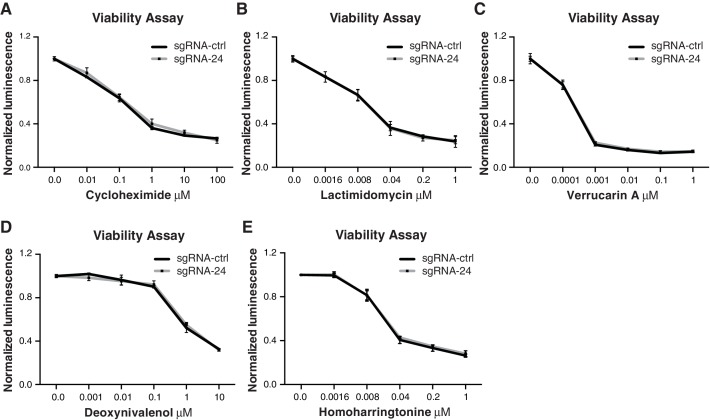
Effects of specific ribosome targeting drugs on the growth of HCC cells lacking SNORA24-guided rRNA modifications.Graphs show mean ± SD normalized luminescence from CellTiter-Glo Luminescent Cell Viability Assay 48 hrs post-treatment of HuH-7 sgRNA-ctrl (black line) or sgRNA-24 (gray line) cells with increasing concentrations of (A) Cycloheximide (B) Lactimidomycin (C) Verrucarin A (D) Deoxynivalenol, and (E) Homoharringtonine from three independent experiments. Statistical analysis was performed using an unpaired Student’s t-test.